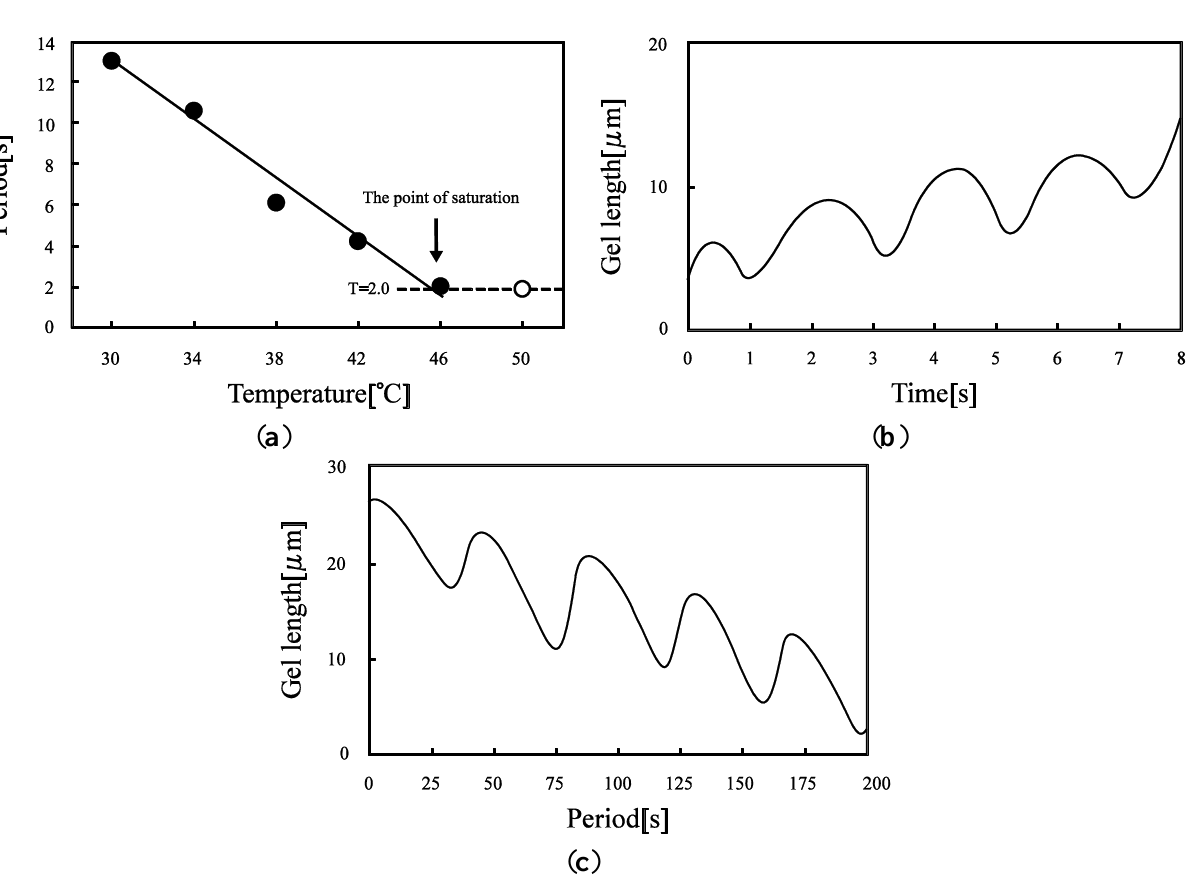
Figure 12. ( a ) Dependence of the self-oscillation period on the temperature. Filled (●) and open (○) circles show the linear relation and the saturated line vs. temperature, respectively. ( b ) Self-oscillating profile of cubic poly(VP-co-Ru(bpy) ) gel at 50 °C 3 ([MA] = 0.08 M, [NaBrO ] = 0.48 M, and [HNO ] = 0.48 M). ( c ) Self-oscillating profile of 3 3 cubic poly(VP-co-Ru(bpy) ) gel at 20 °C ([MA] = 0.08 M, [NaBrO ] = 0.48 M, and 3 3 [HNO ] = 0.48 M). The cubic gel (side lengths of about 2 mm and 20 mm) was immersed 3 in 8 mL of the mixed solution of BZ substrates. (Reprinted from [45], Copyright American Chemical Society. Reproduced with